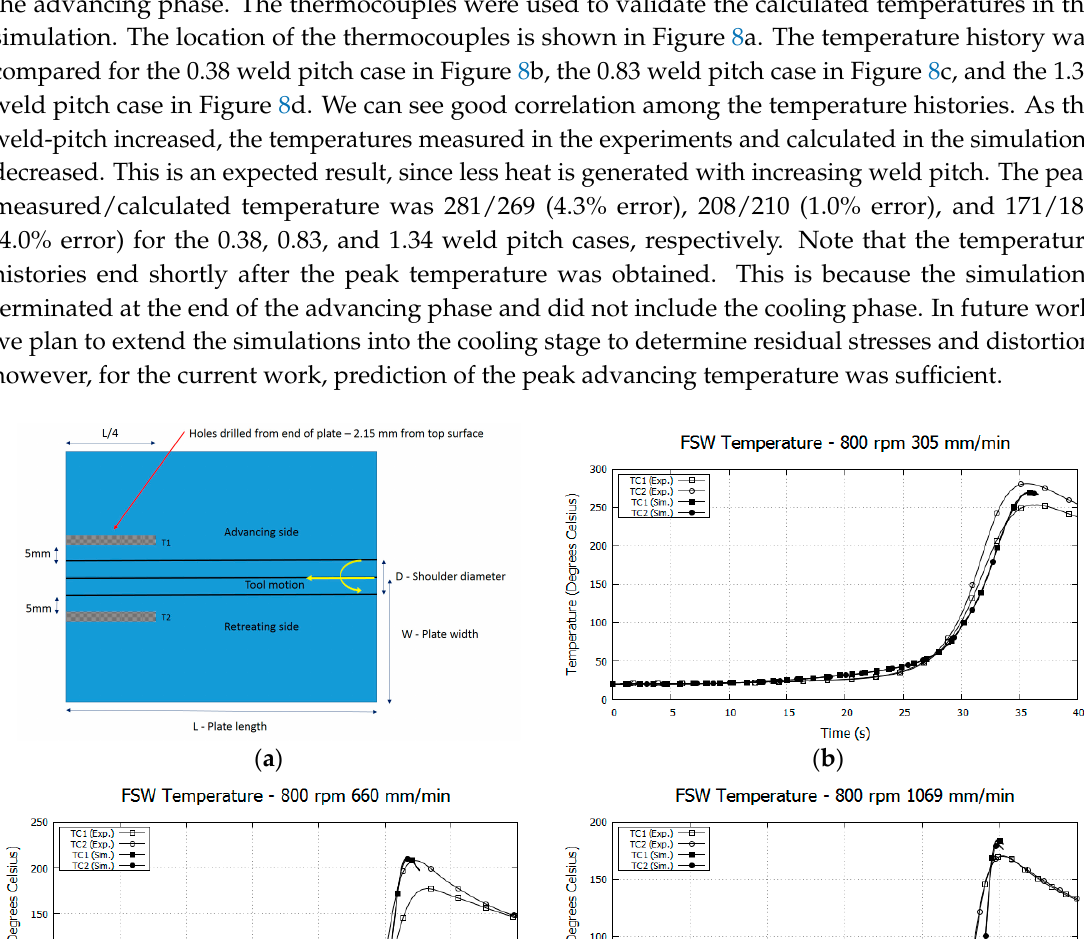
Figure 9. Comparison of temperature contours at the end of the advancing phase between the ( a ) numerical and ( b ) experimental results for 800 rpm with 1069 mm/min advance speed.